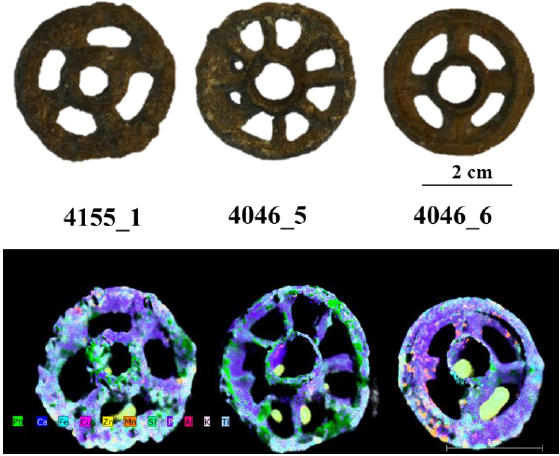
Figure 3. Photographs of the three ornamental jewellery objects and the XRF mapping of the detected elements.